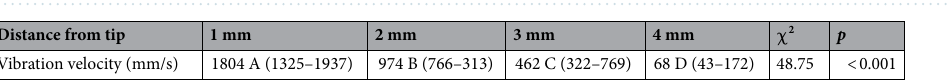
Figure 3. Frequency and amplitude of the vibratory resin applicator. ( A ) Vertical direction. ( B ) Horizontal direction.